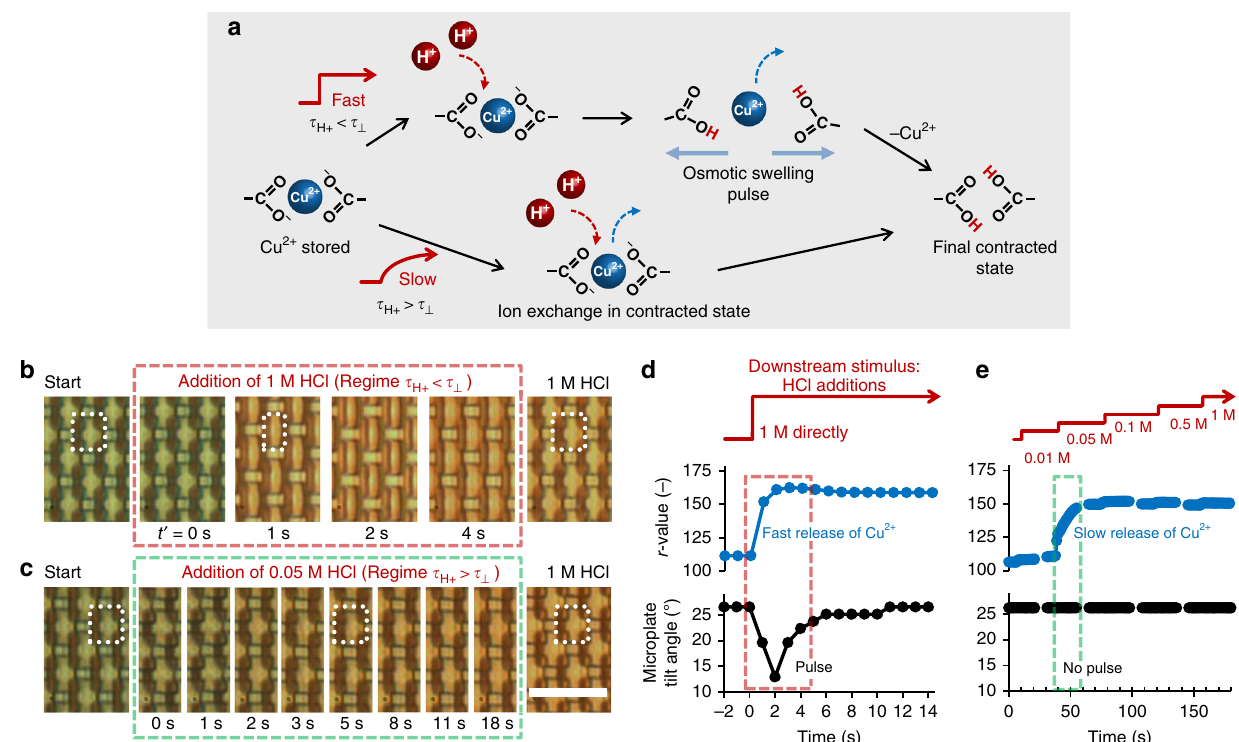
Fig. 3 Cu 2 + ions generate a transient osmotic swelling pulse upon rapid release by an acid stimulus. a Schematic presentation of the mechanism, showing how acid delivered after Cu 2 + has been removed from the external environment of the hydrogel protonates carboxylate groups and thereby releases the complexed Cu 2 + . Fast release would generate an osmotic swelling pulse (top) before acid contracts the hydrogel again, while slow addition of acid should lead to a slow Cu 2 + release without transient swelling (bottom). b Experimental demonstration of the fast Cu 2 + release (regime τ H + < τ ⊥ ), triggered by direct addition of concentrated 1 M HCl, which results in rapid disappearance of the blue color and transient reorientation of the microplates to an upright position. The dotted outlines indicate the change of the cross-sectional view of a single plate from nearly square (in the tilted state) to rectangular (in the upright state), and back to nearly square. c Stepwise addition of acid leads to a slow release of Cu 2 + , such that the gel remains contracted without transient swelling (regime τ H + > τ ⊥ ). Scale bar: 25 μ m. d , e Time-dependent microplate tilt angle and r value (acid stimulus added at t = 0) for fast ( d ) and stepwise, slow ( e )